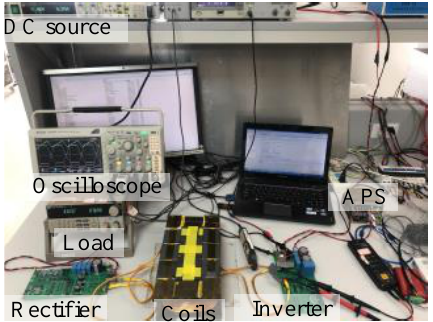
Figure 7. Photograph of the 100 kHz single-ended WPT systems.